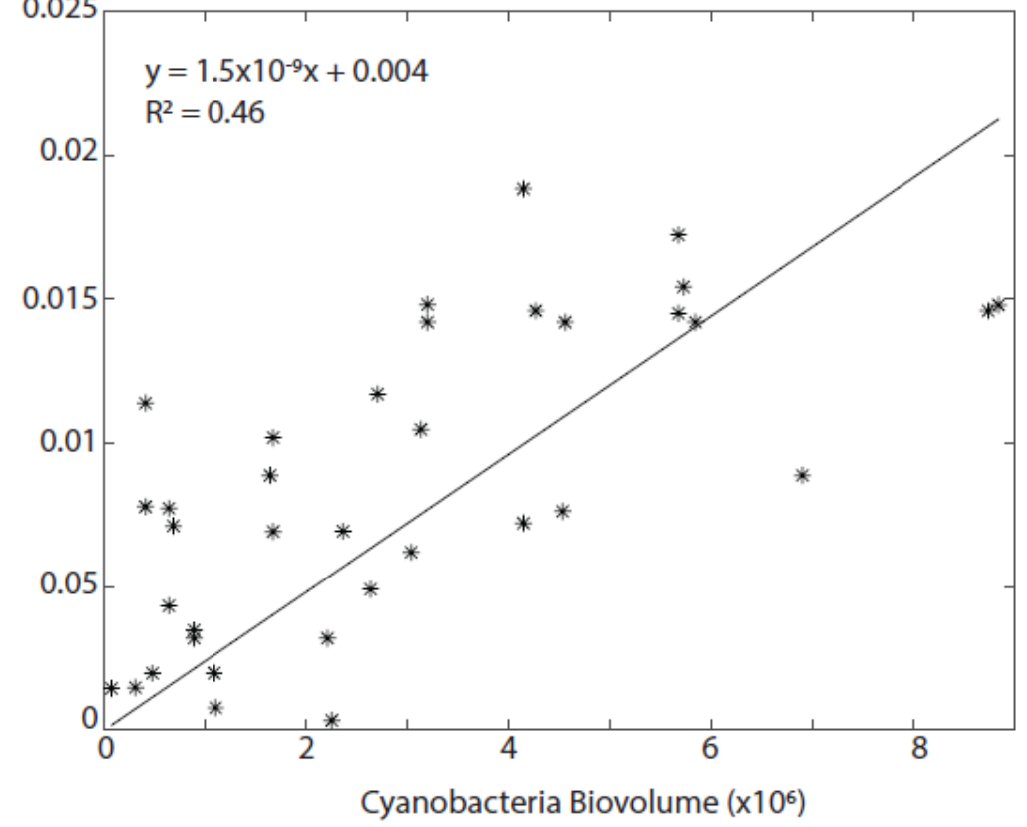
Figure 4. Linear regression between field-based cyanobacteria biovolume and the remotely sensed based CI cyano algorithm.